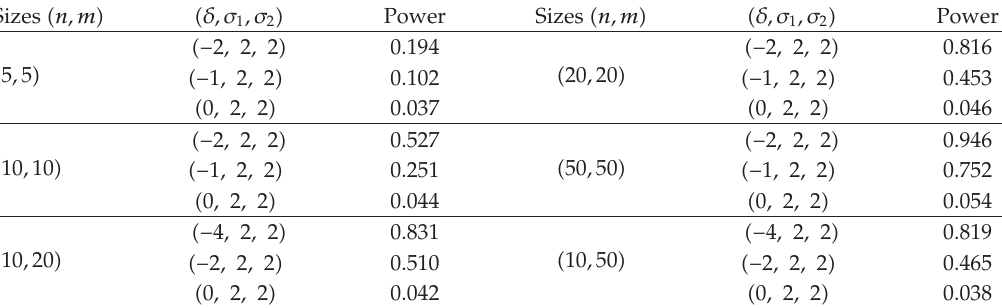
Table 2: The simulated powers for δ (cid:2) the location-scale family in (cid:2) 4.8 (cid:3)(cid:3)